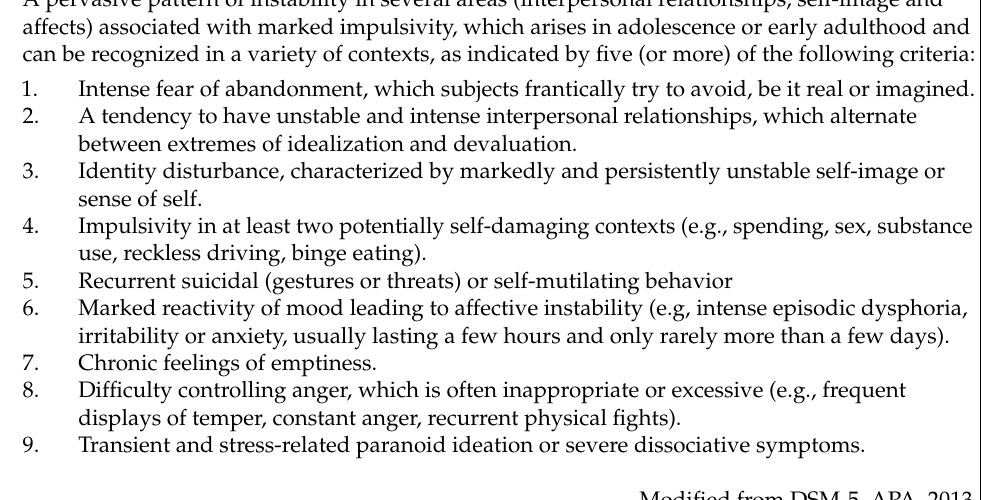
Box 1. DSM-5 diagnostic criteria for borderline personality